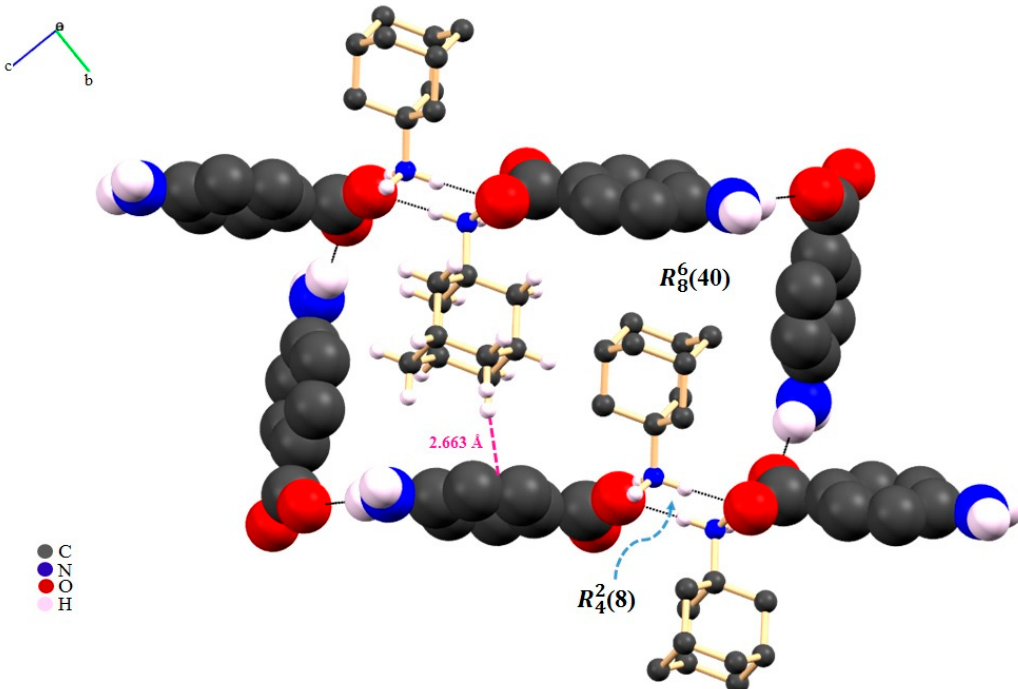
Figure 16. Packing interactions highlighting the R 2 2 (8) synthon between ADA and 4-AMINO molecules (N-H + (ADA) ··· O − (4-AMINO) HB). The presence of the N-H ··· (4-AMINO) ··· O - (4-AMINO) HB interaction allows the R 6 8 (40) synthon, where ADA aliphatic domains face each other. Some aliphatic hydrogen atoms were omitted for clarity [76].